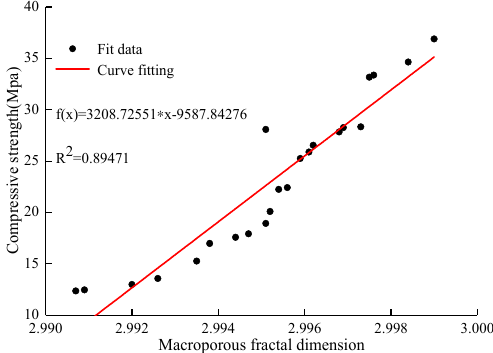
Figure 5. Fitting relationship between fractal dimension of macropores and compressive strength.